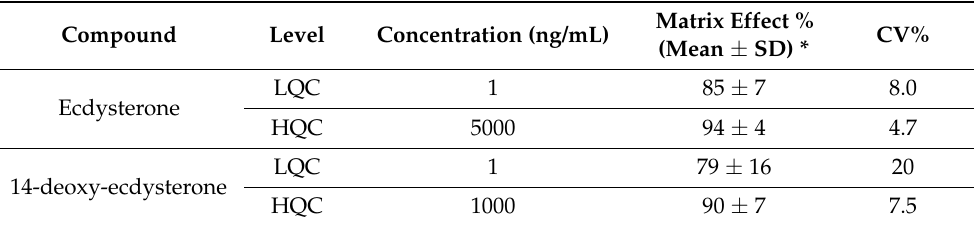
Table 3. Evaluation of matrix effects of ecdysterone and 14-deoxy-ecdysterone in human urine samples.